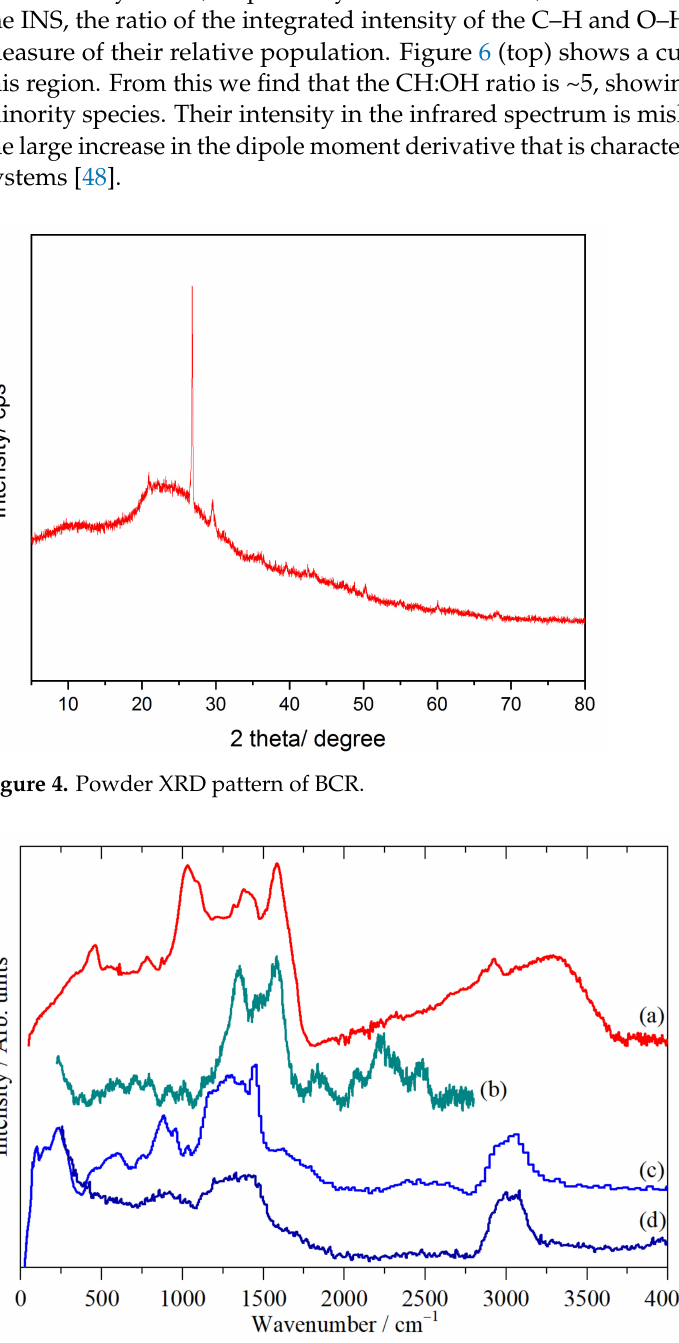
Figure 5. Vibrational spectra of BCR: ( a ) infrared at 298 K, ( b ) Raman at 298 K, ( c ) and ( d ) INS at 20 K recorded with TOSCA and MAPS,